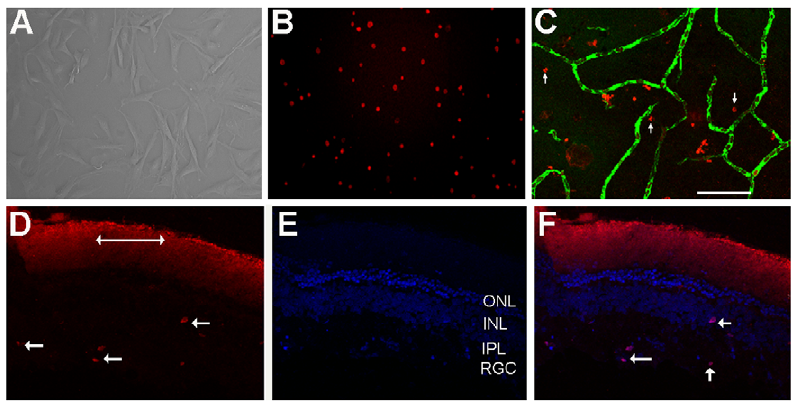
Figure 5. Distribution of MSCs. A. phase contrast microphotograph of bone marrow derived mesenchymal stem cells at passage 2. B. MSCs were preincubated with PKH26 before intravenous injection. C. PKH26 labeled MSCs in the retina two weeks after intravenous injection (arrows); blood vessels were perfused with FITC-dextran (green). D–F. showing PKH26 labeled MSCs in the retinal section (D, arrows pointing PKH26 labeled MSCs; double arrows indicating background staining in debris zone); sections counterstained with DAPI (E); F. merged image from D&E showing PKH26 labeled MSCs counterstained with DAPI (scale bar equals 100 m m).